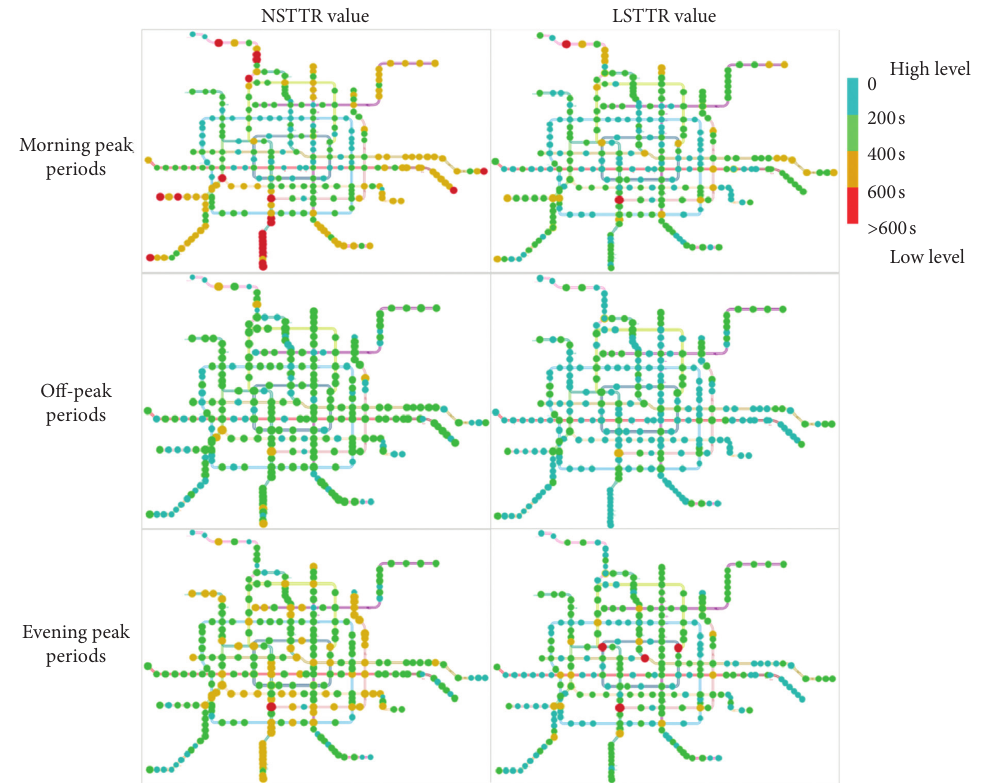
Figure 7: The visualization of NSTTR and LSTTR.